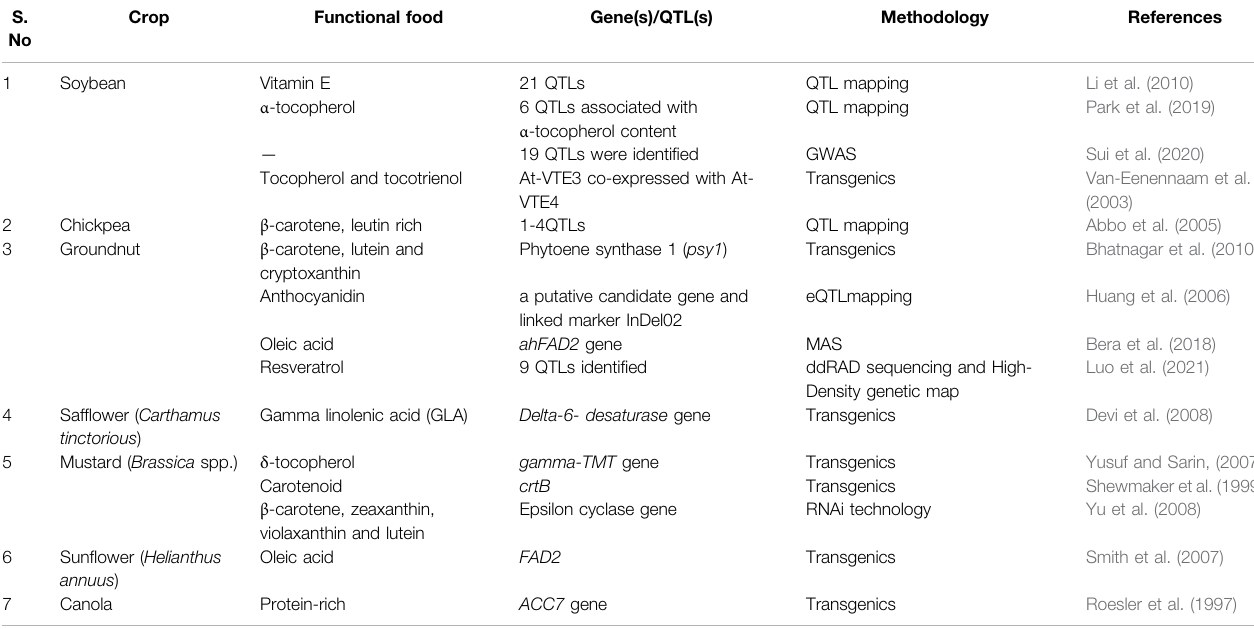
TABLE 3 | Study of functional foods in pulses and oilseeds using biotechnological approaches. S.